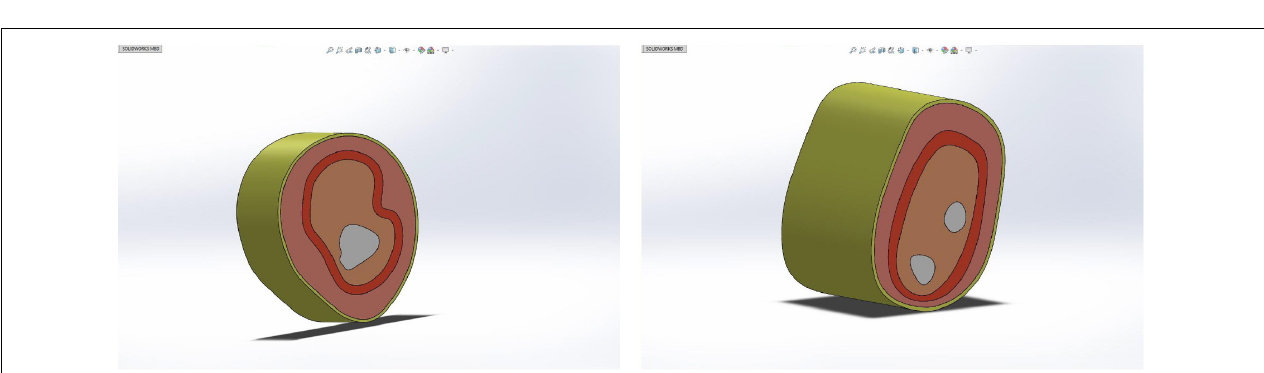
FIGURE 5 | Simplified model of human upper limb: (A) simplified schematic of upper arm middle model and (B) simplified schematic of forearm middle model.